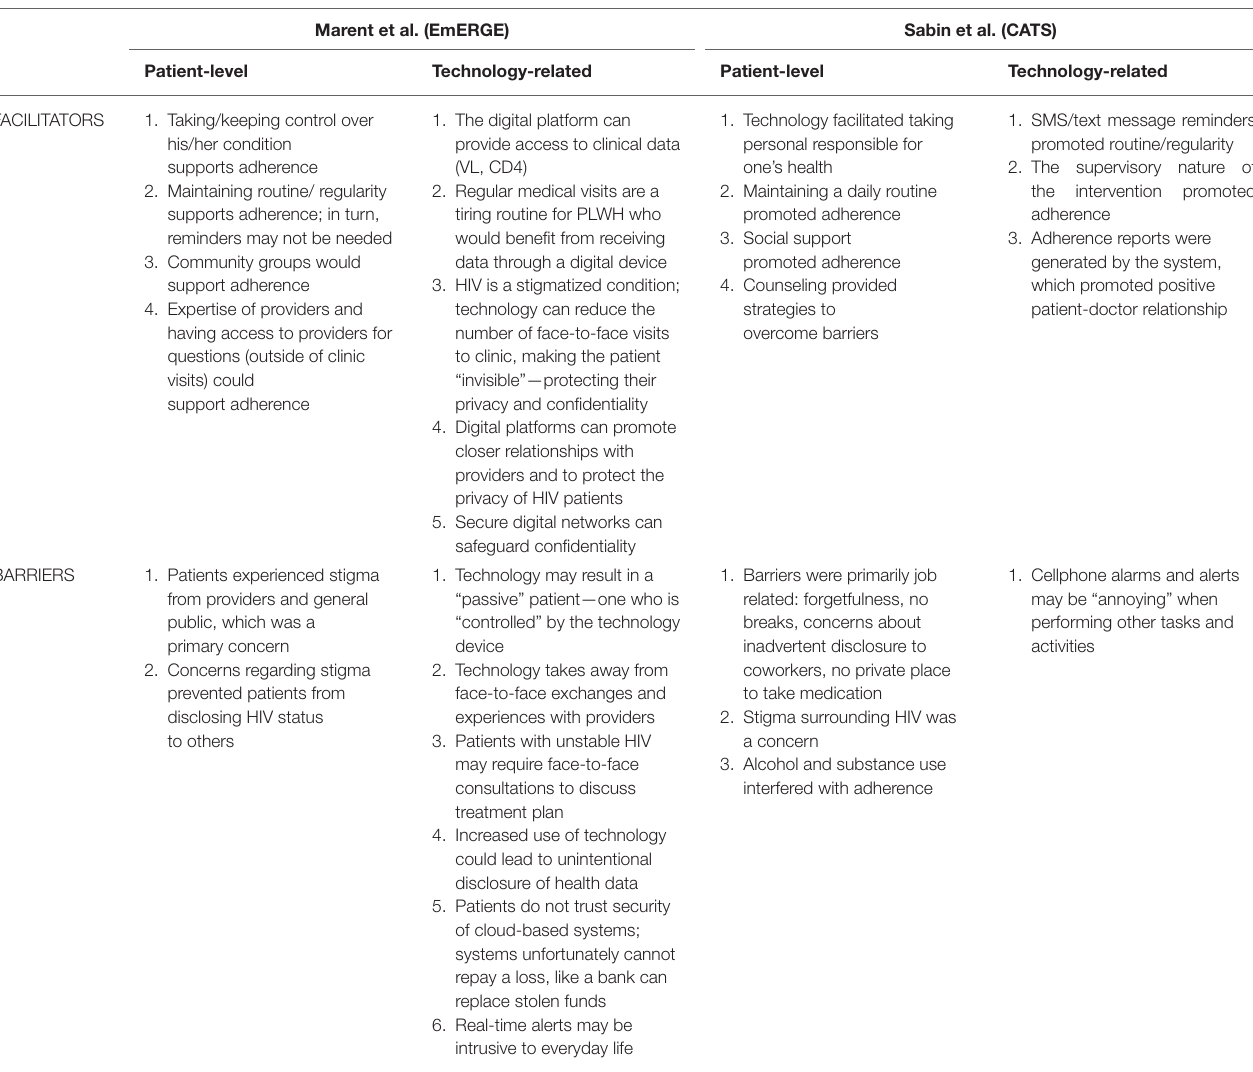
TABLE 2 | Summary of facilitators and barriers to HIV care, identified by the target population (PLWH): qualitative findings from the mHealth articles